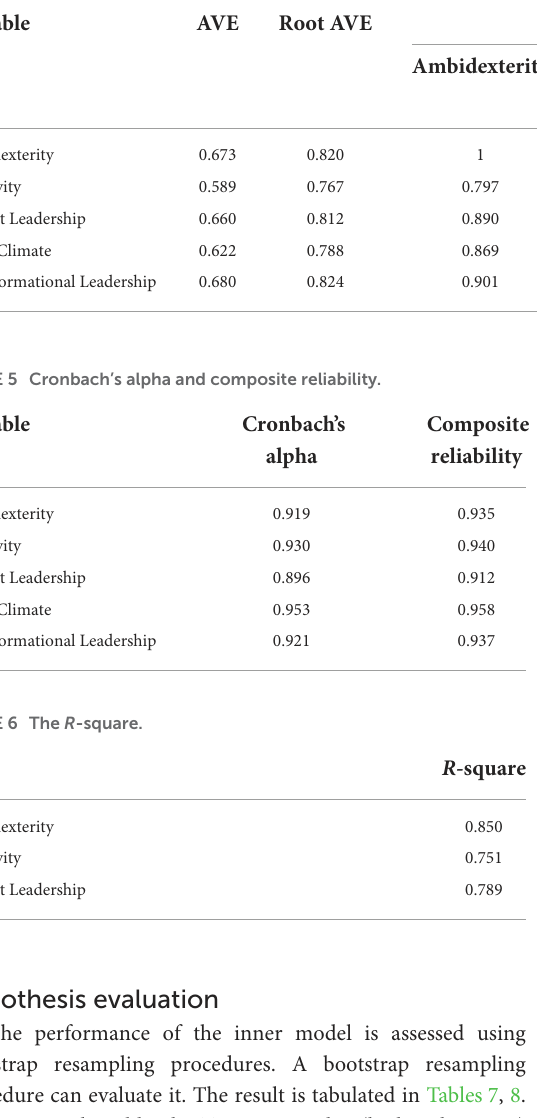
TABLE 4 The root of AVE and correlation between variables.